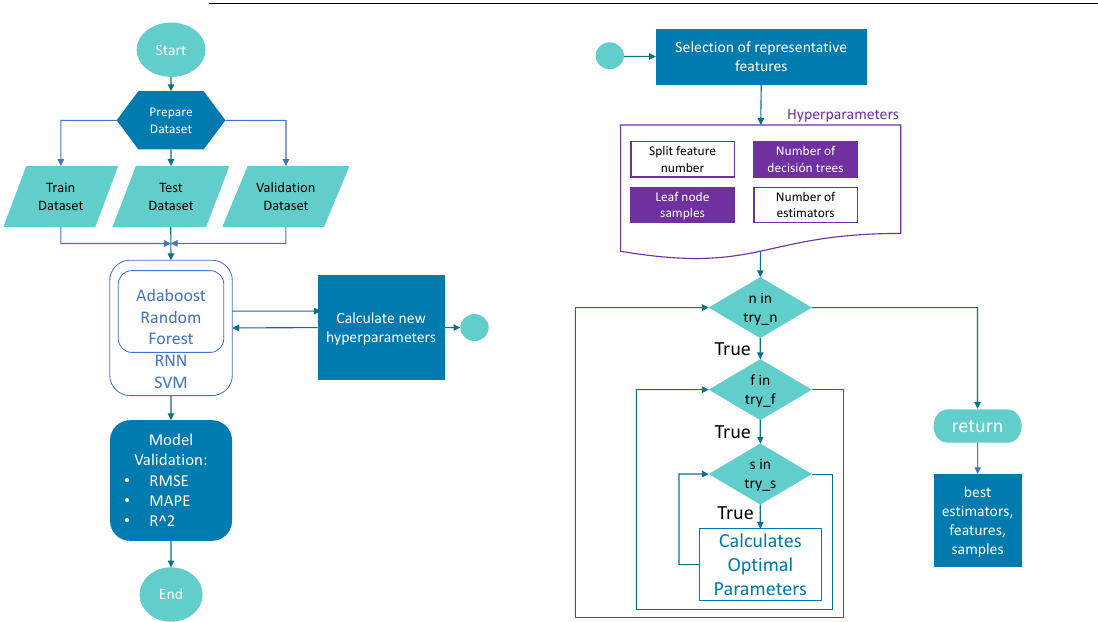
Figure 3. Flowchart with the proposed improvements applied to random forest regression